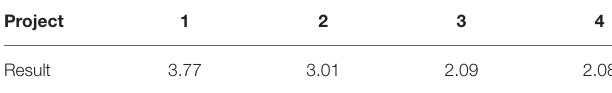
TABLE 5 | The average value of the teaching method